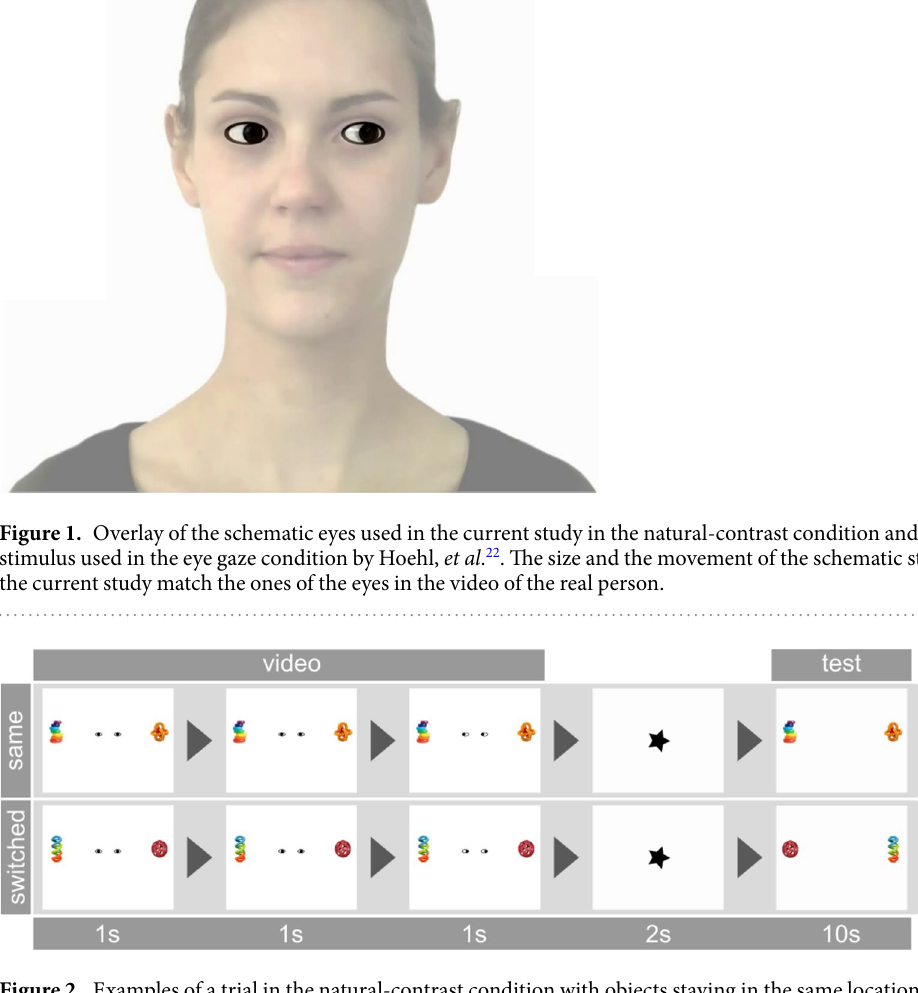
Figure 2. Examples of a trial in the natural-contrast condition with objects staying in the same location or switching positions in test. Stimulus presentation in the reversed-contrast condition was identical except for the contrast polarity of the central